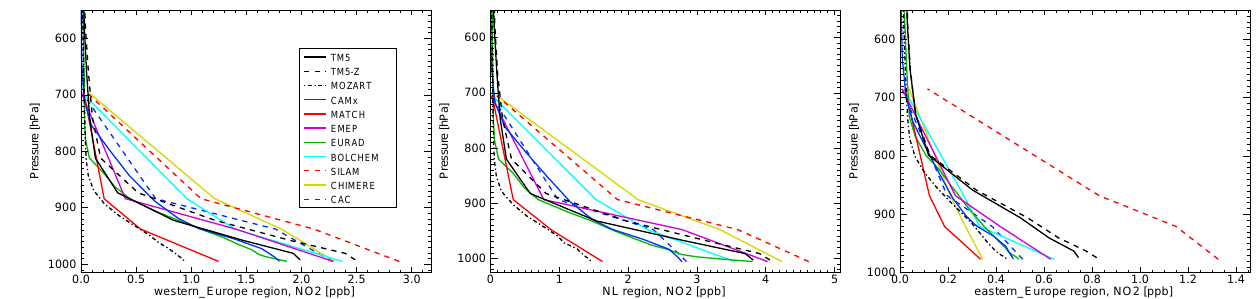
Fig. 8. Monthly mean, area-averaged profiles for August at 12:00UTC. No cloud filtering is applied for these averages.